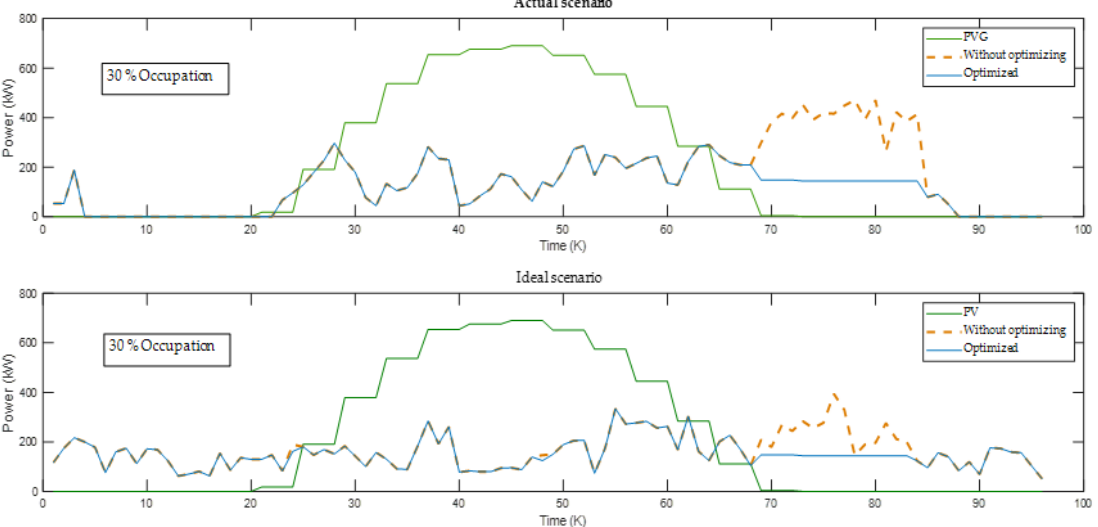
Figure 15. Demand optimization in the 30% scenario (real and ideal load